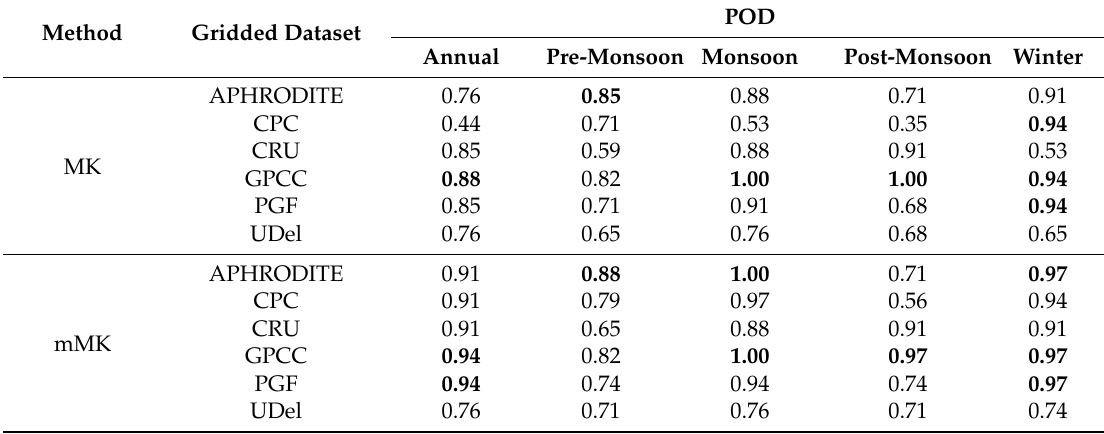
Table 6. The Probability of Detection (POD) score of the different gridded datasets in detecting trends obtained using observed data for the period 1979–2010. The highest values of POD for annual and seasonal rainfall are shown in